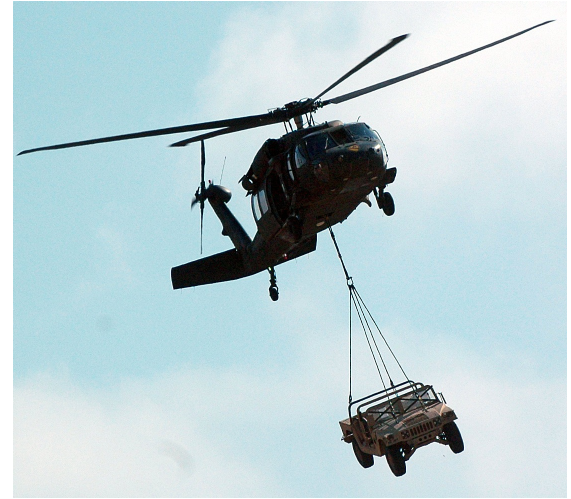
Figure 1. Blackhawk helicopter maneuvering with a military vehicle slung underneath. From [99], Courtesy US Army. Work of the US